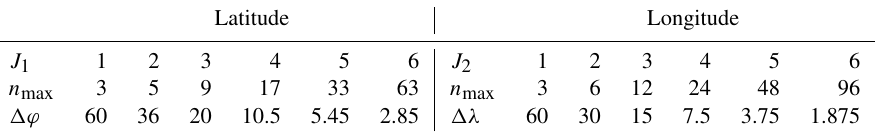
Table 1. Numerical values for the B-spline levels J 1 and J 2 , the maximum SH degree n max and the input data sampling intervals (cid:49)ϕ and (cid:49)λ by evaluating the inequalities from Eq. (33); the left part of the table presents the numbers along a meridian (upper inequalities in Eq. 33), and the right part represents the corresponding numbers along the Equator and its parallels according to the lower inequalities in Eq. (33).